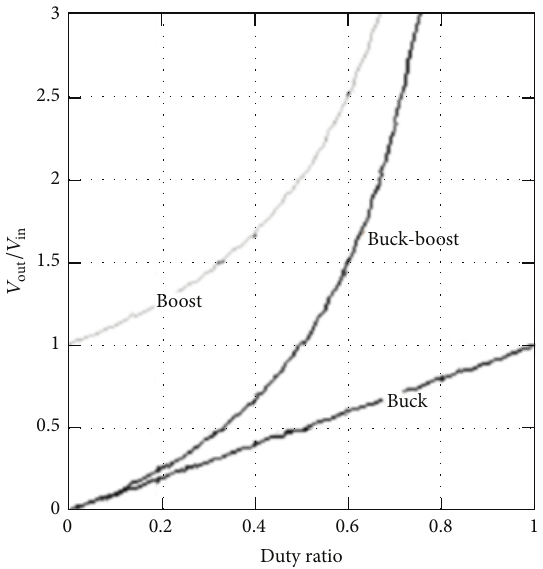
Figure 3: Comparison of duty ratio in buck, boost, and buck-boost converter, Brey et al.